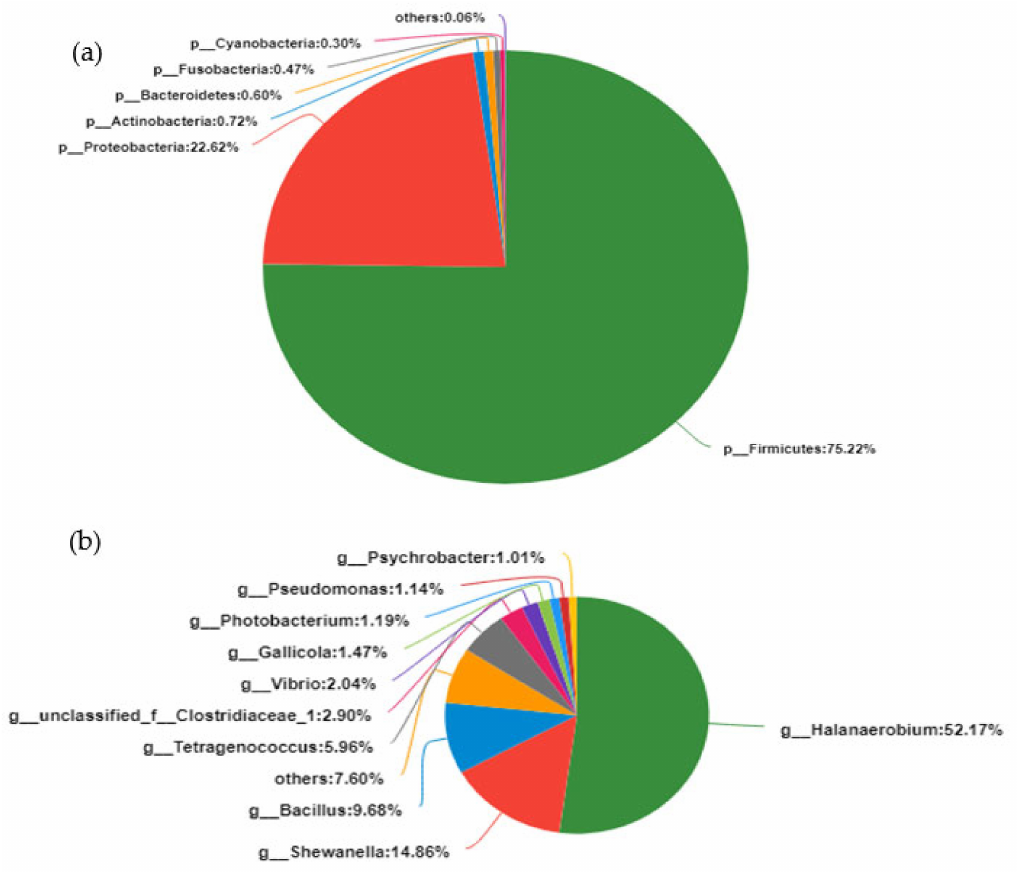
Figure 4. Pie diagram analysis of bacterial structure in the whole fermentation process of fish sauce at the phylum ( A ) and genus ( B )